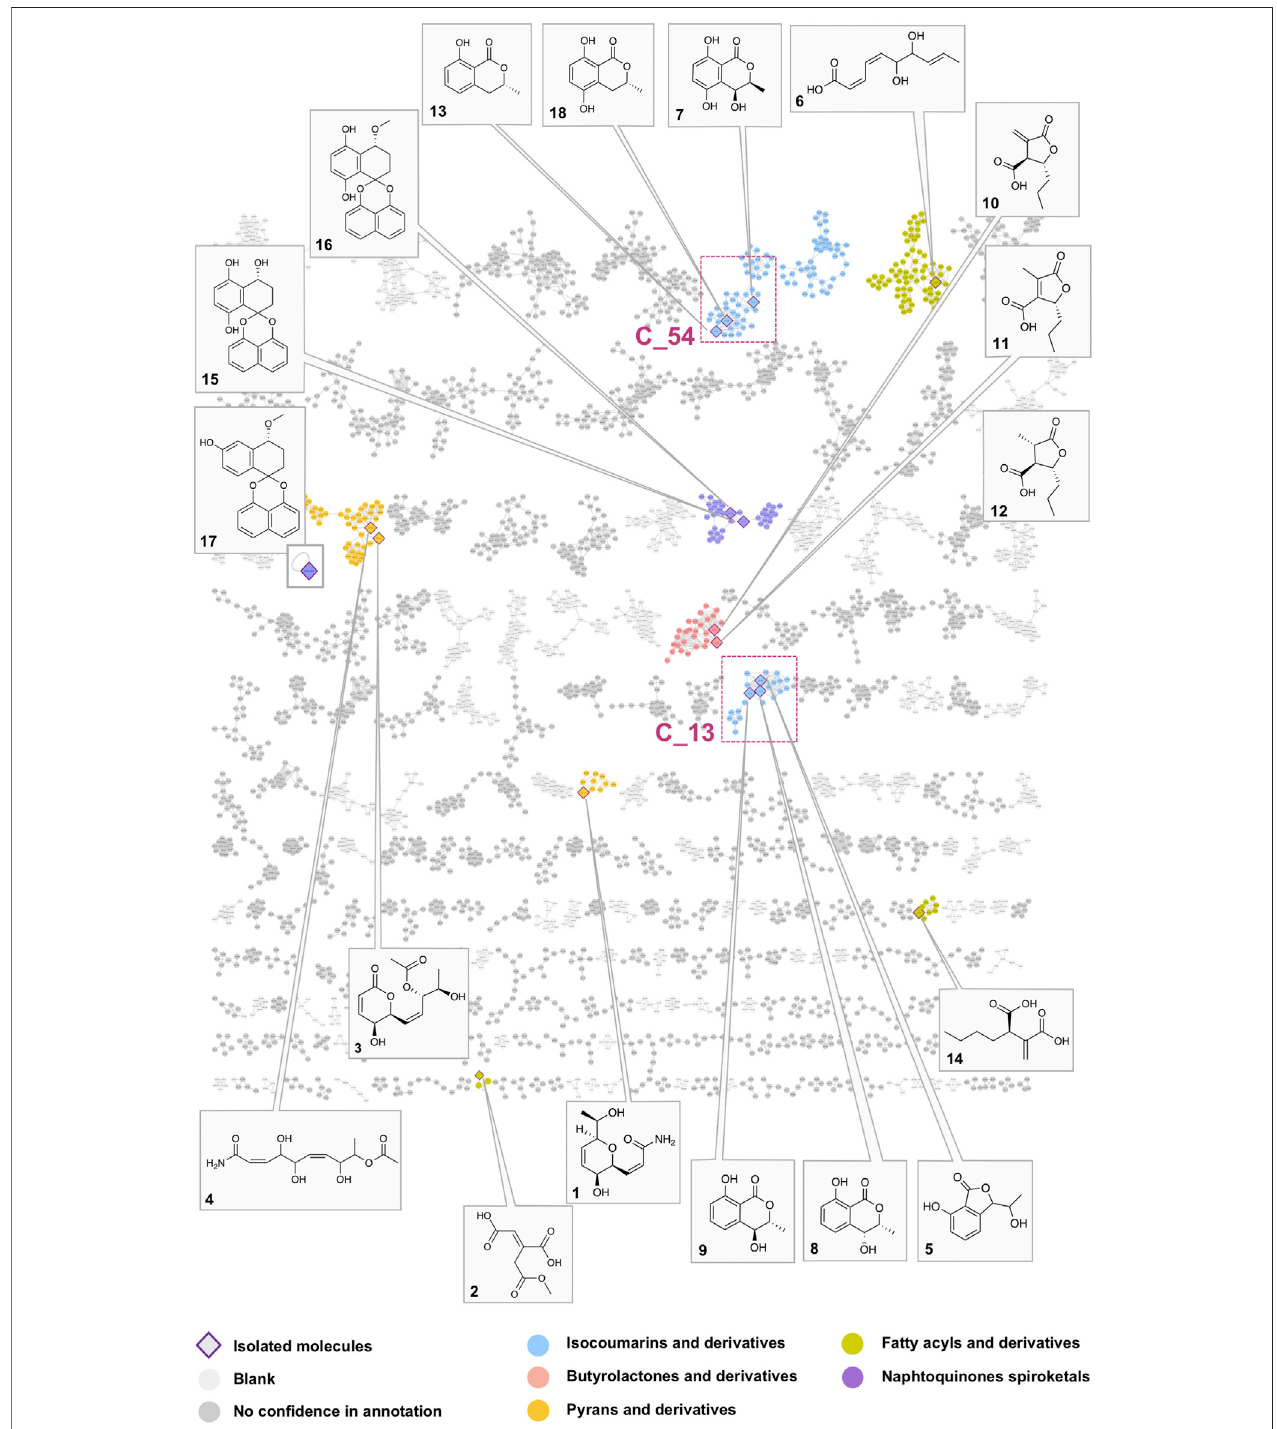
FIGURE3| GlobalmolecularnetworkoftheA02EtMextractandthe33semi-preparativefractionswithattributionofthenodesofallpurecompoundsisolatedfrom theHPLCsemi-preparativepuri fi cationandtheircorrespondingclusters.Colorsofthenodescorrespondtochemicalfamiliestentativelyassignedtotheclustersthrough the use of a consensus structural annotation at different Classy fi re taxa levels. Clusters C_54 and C_13, highlighted with red squares, are annotated as benzopyran derivatives (C_54 with the active compound 18 and isolated analogs 7 and 13) (C_13 with compounds 5, eight and 9). A detailed view of the selected clusters is displayed in Figure 6